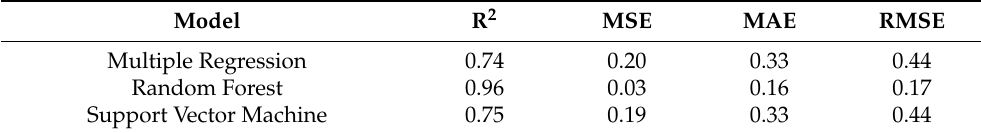
Figure 12. Actual vs. predicted UTS. Table 6. Model Performance Evaluation.